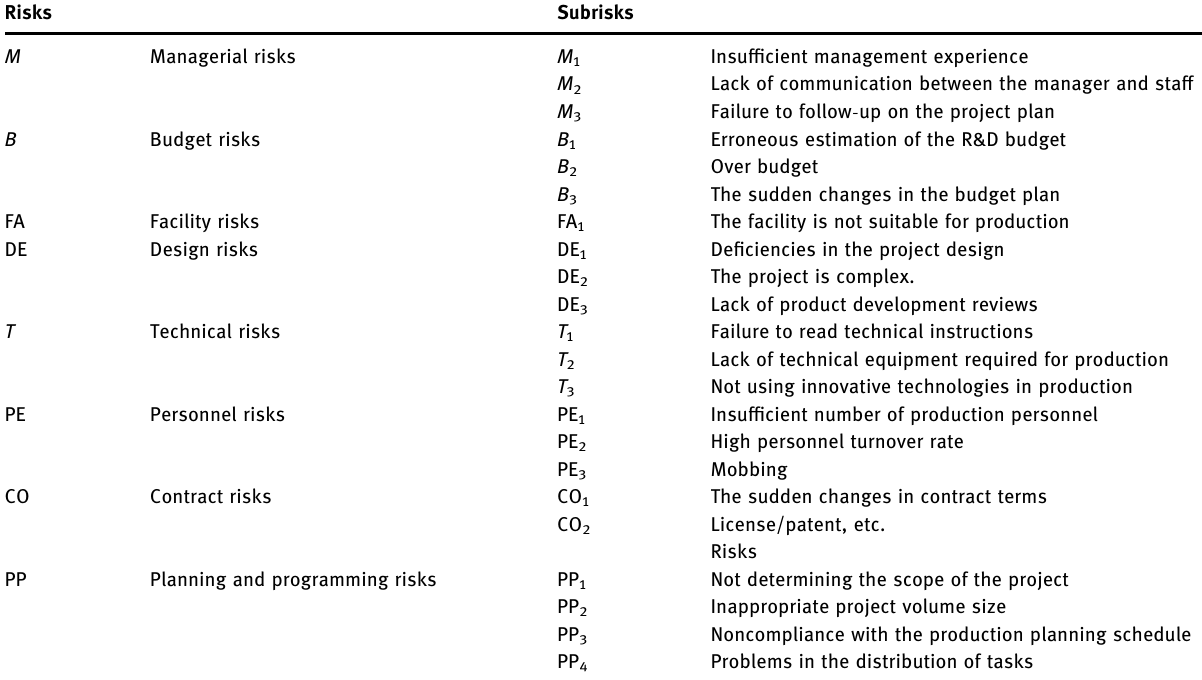
Table 5: Internal risks were a ff ecting the product development process Risks